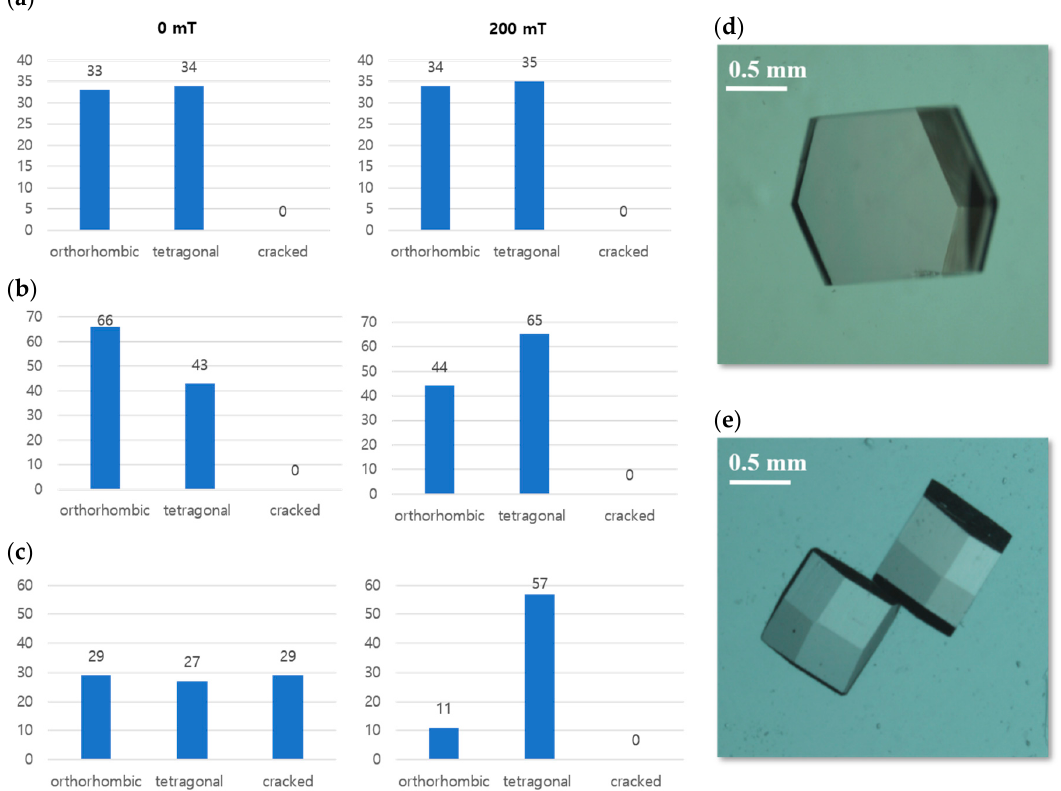
Figure 5. Number of HEWL crystals with and without a magnetic field. ( a ) pH 5.0, ( b ) pH 5.5, ( c ) pH 6.0, ( d ) orthorhombic crystals, and ( e ) tetragonal crystals.